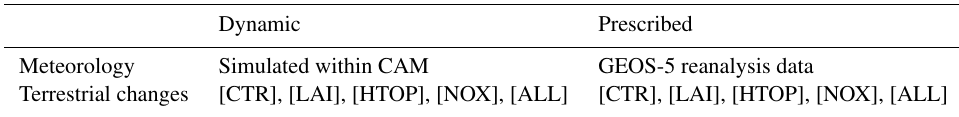
Figure 1. Biogeochemical and biogeophysical pathways of nitrogen deposition affecting surface ozone concentration. Biogeochemical path- ways via canopy height (yellow), leaf area index (LAI; green), and soil NO x (blue), as well as some of the biogeophysical pathways relevant for this study (red) are shown. The sign associated with each arrow indicates the correlation between the two variables; the sign of the overall effect (positive or negative) of a given pathway is the product of all the signs along the pathway. Biogeochemical pathways affect gas exchange (i.e., biogenic VOC emission and ozone deposition) though plant stomata or microbe-mediated soil processes. Biogeophysical or meteorological pathways are mediated through a modification of the local and nonlocal overlying meteorological environment above the surface layer. Table 1. Meteorological inputs for simulations with dynamic and prescribed